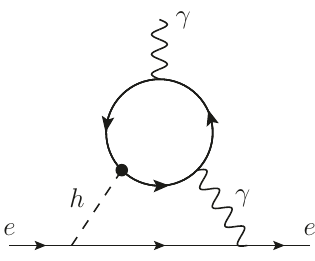
Figure 1 . Barr-Zee type diagram giving rise to the contribution to the electron